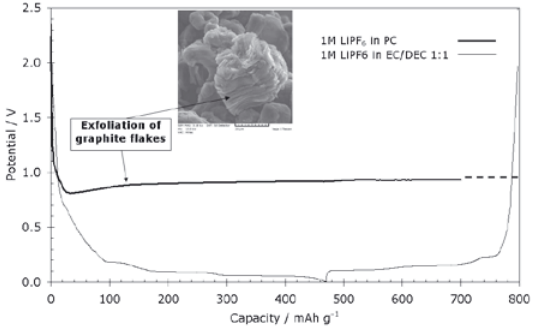
Figure 1. Galvanostatic charge/discharge curves recorded for a graphite electrode in electrolytes based on PC (thick line) and EC/DEC (thin line) as solvents; in the inset - SEM micrograph taken from graphite electrode charged in PC.